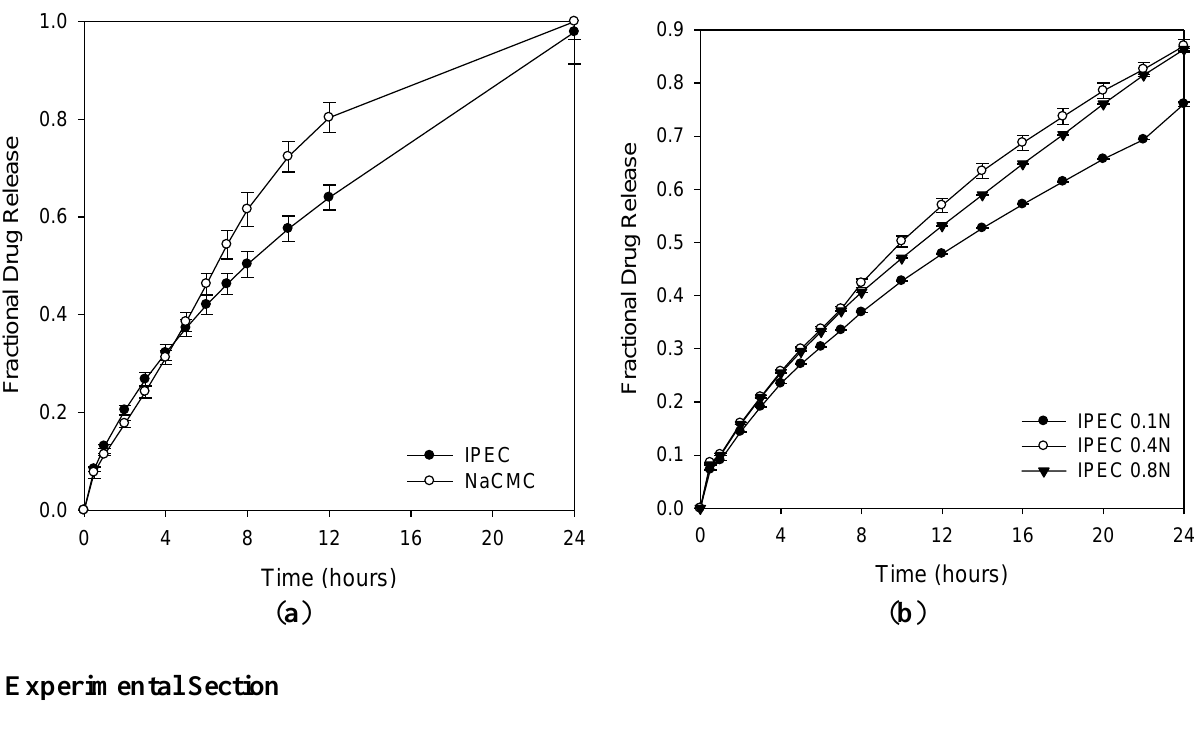
Figure 12. Comparative in vitro drug release profiles of ( a ) NaCMC and IPEC; and ( b ) IPEC at different normalities of acetic acid: 0.1 N, 0.4 N and 0.8